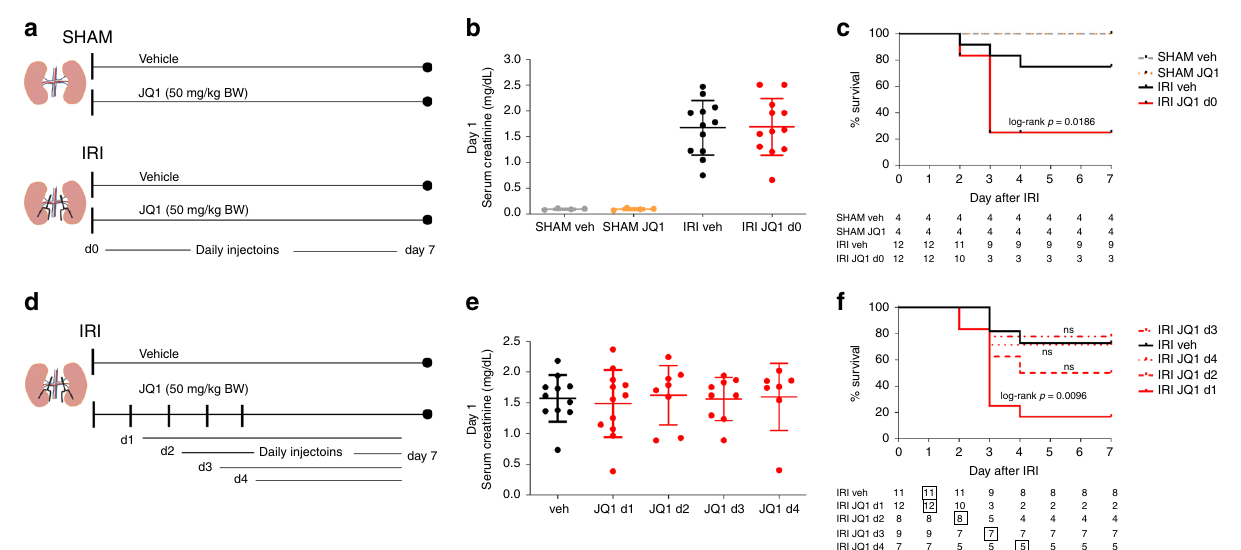
Fig. 5 Phenotypic consequences of BET inhibition after experimental AKI. a C57BL/6N mice (10- to 12-week-old males) were treated daily starting at the day of SHAM or IRI surgery (d0) with JQ1 (50 mg/kg BW) or vehicle (DMSO/10% ß-cyclo dextrin 1:10). b Serum creatinine (mg/dL) values in SHAM and IRI animals with vehicle or JQ1 at day 1 after surgery are shown (individual data points and mean ± SD). SHAM: n = 4; IRI: n = 12 biologically independent samples. c Survival curves after IRI surgery (ischemic time was 26 min at 37 °C). JQ1 treatment leads to 80% mortality after IRI surgery. Table shows number of animals alive at indicated days. d Experimental design of delayed treatment with JQ1 (50 mg/kg BW) after IRI starting at day 1, day 2, day 3 or day 4. e Serum creatinine levels at day 1 after IRI, verifying that AKI was induced to a roughly equivalent extent in each of the groups of animals that were subsequently treated with JQ1 (individual data points and mean ± SD). IRI veh: n = 11; IRI d1: n = 12; IRI d2: n = 8; IRI d3: n = 9; IRI d4: n = 7 biologically independent samples. f Survival curve after delayed JQ1 treatment starting day 1, day 2, day 3 or day 4. Table indicates number of animals alive at each day. Box indicates start of vehicle or JQ1 treatment. Source data are provided as a Source data fi